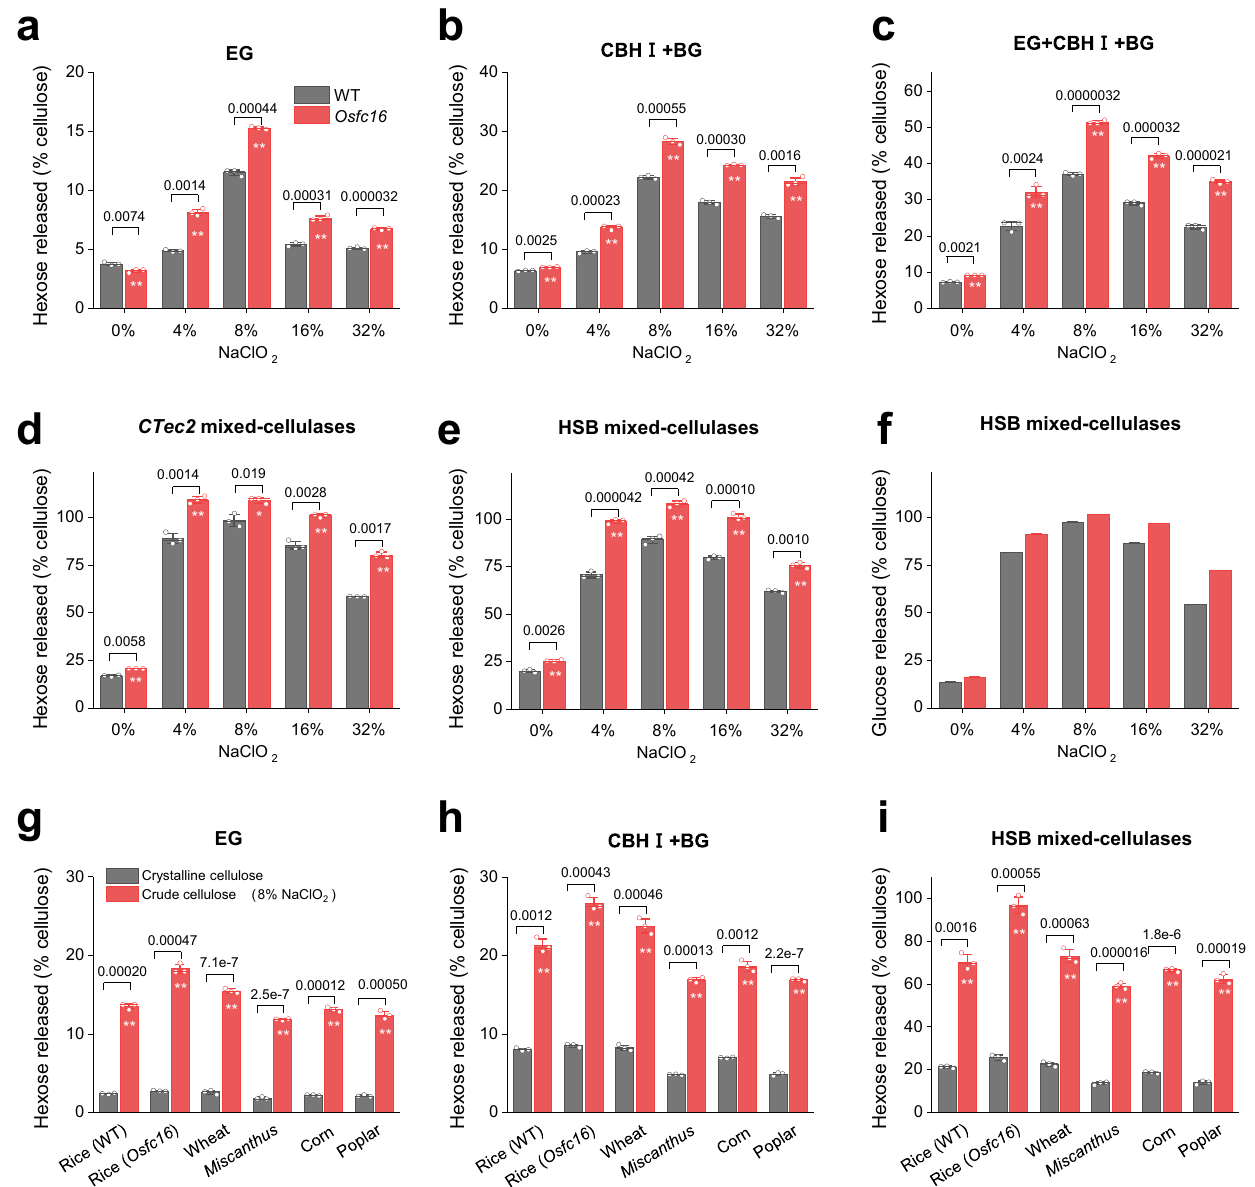
Fig. 5 | CMFs integrity and CNF length for enzymatic sacchari fi cation. a – e Measurementof hexose(glucose)yields(%cellulose)released fromenzymatic hydrolyses with de-lignin powders samples of Osfc16 mutant and WT in vitro. Hexoseyieldsbydifferentformulasofenzymeswithsinglecellulaseorcommercial mixed-cellulases. f Glucose yields by GC/MS analysisof hexose in e , data extracted from GC/MS spectroscopic pro fi ling. g – i Hexose yields released from enzymatic